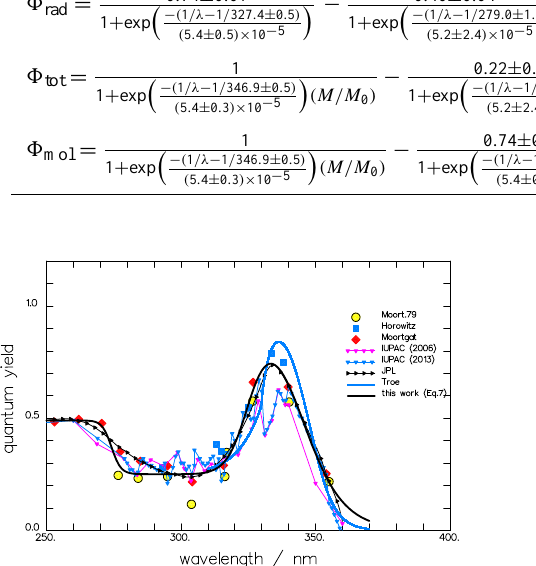
Figure 3. Spectrum of the quantum yield of the molecular branch of the CH 2 O photolysis at room temperature. Measured data used for the fit are indicated by the large filled symbols (Moort.79: Moortgat and Warneck, 1979; Horowitz and Calvert, 1978; Moortgat et al., 1983). The present fit and the theoretical curve from Troe (2007) are given by full lines. Recommended data are represented by small symbols connected by a thin line: JPL (Sander et al., 2011), and IUPAC (2006,